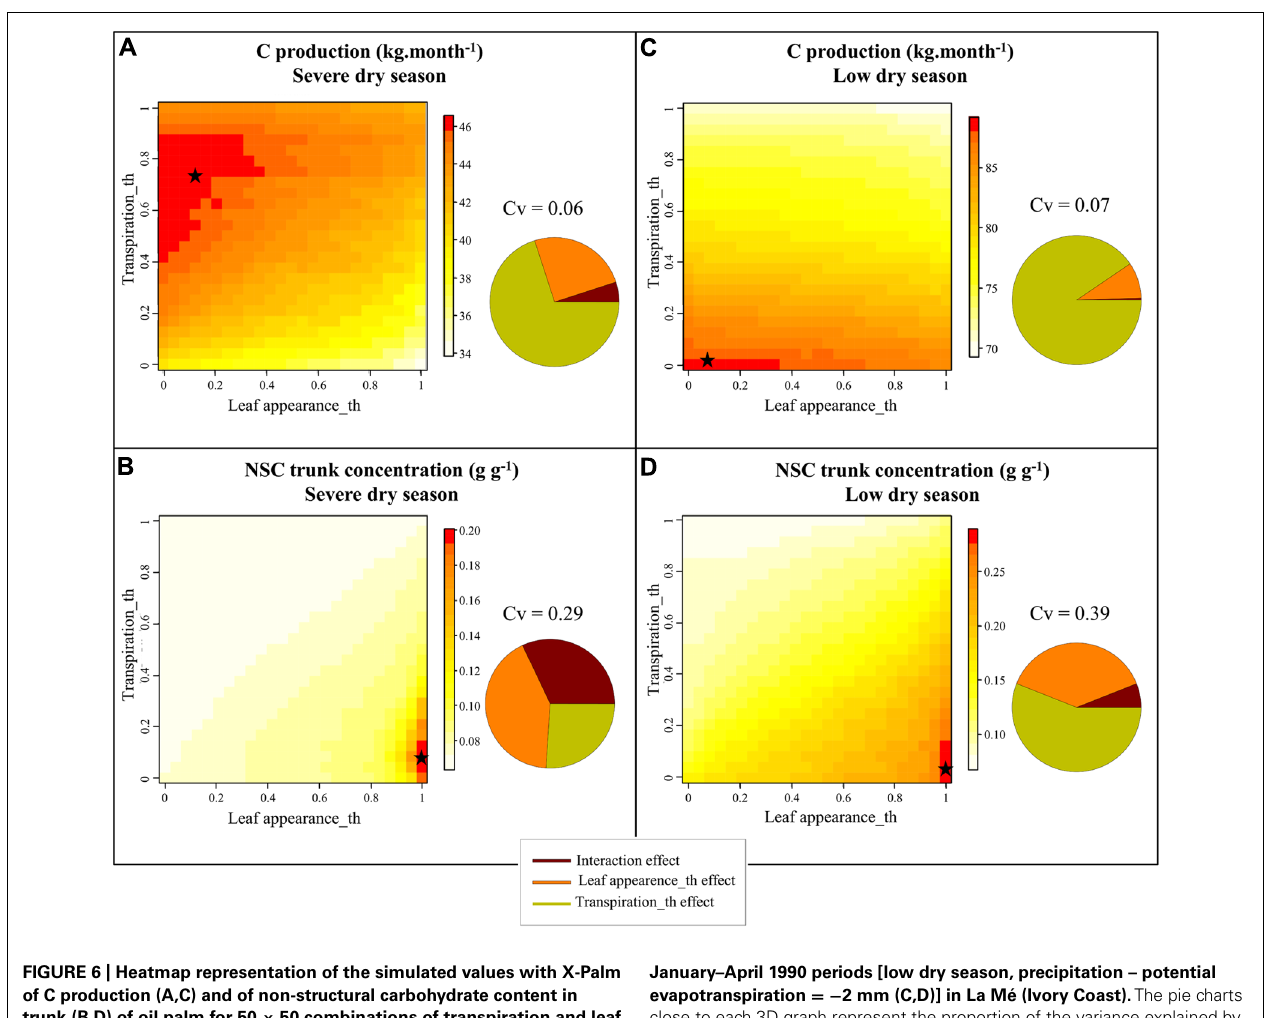
January–April 1990 periods [low dry season, precipitation – potential evapotranspiration = − 2 mm (C,D)] in La Mé (Ivory Coast). The pie charts close to each 3D graph represent the proportion of the variance explained by both parameters and their interaction. Stars refer to the parameter values maximizing plant C production and NSC contents in the trunk for both water deficit